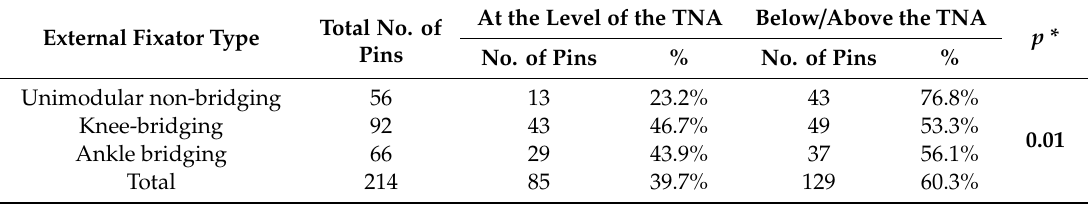
Table 3. External fixator type and topography of the applied pins in relation to the